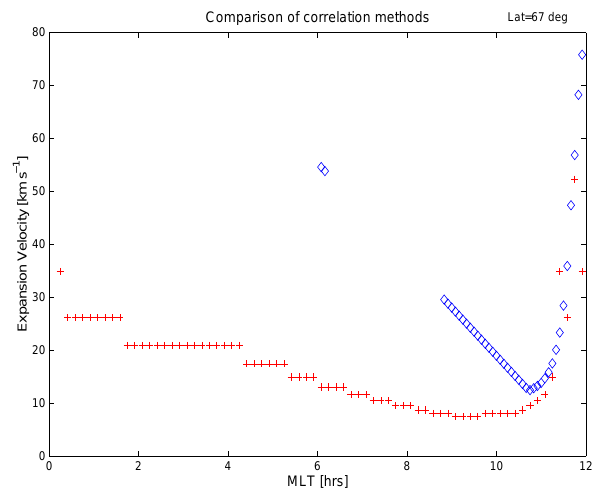
Fig. 4. A comparison of the velocities of the expansion of the model response to reconnection, derived by cross-correlation techniques (methods 1 and 2, respectively). The diamonds show the velocities derived by correlation with a fixed reference station (at 12 MLT), the crosses show the velocities derived using correlation with the adjacent (sunwards)